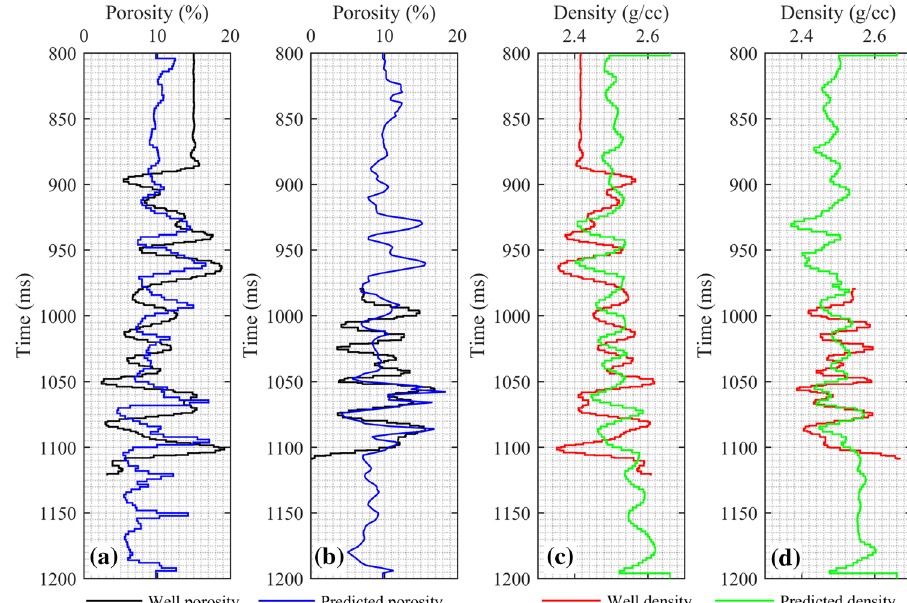
Fig. 9 Comparison of predicted porosity (blue) and actual poros- ity (black) for the a well 01–17, b well 08–08, and comparison of predicted density (green) with actual density (red) for c well 01–17, and d well